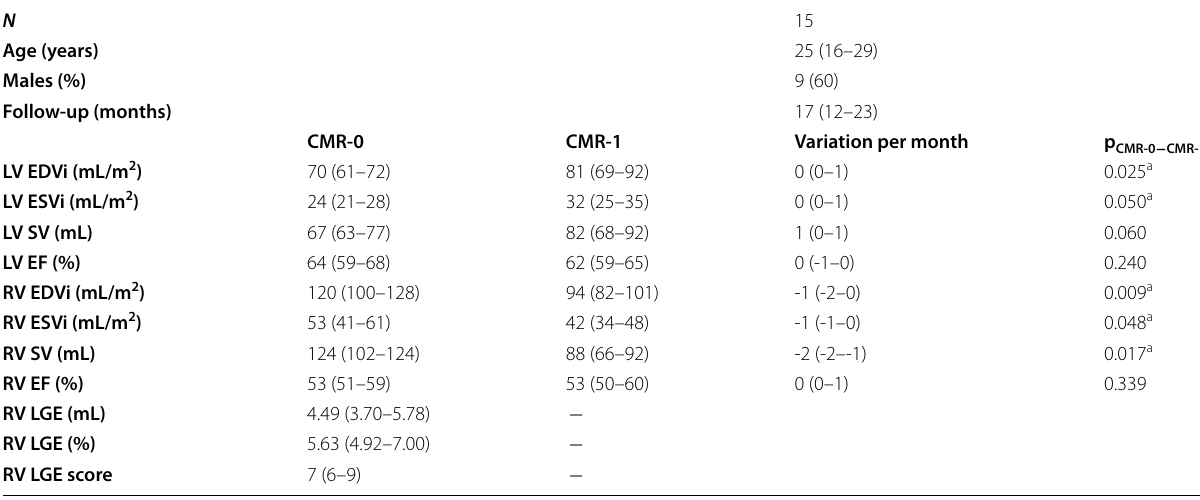
Table 2 Demographics and clinical variables of the study population, including variations over time normalised for the time difference between CMR-0 and CMR-1 in months